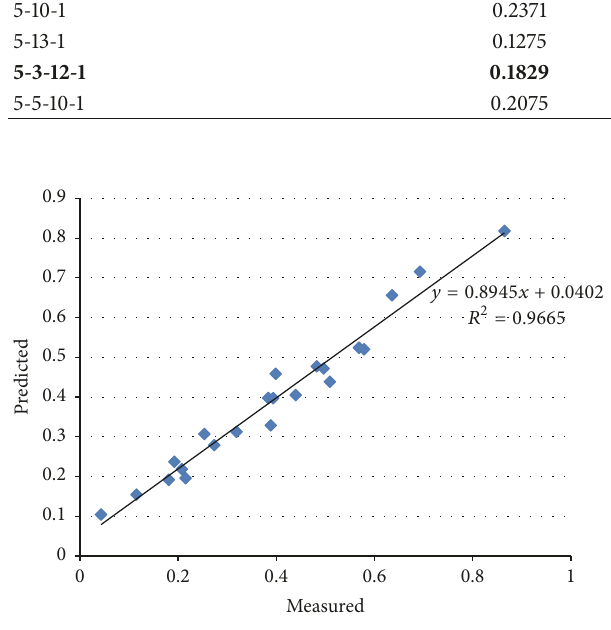
Figure 20: Correlation between predicted settlements versus calcu- lated ones for the best static- dynamic neural network,